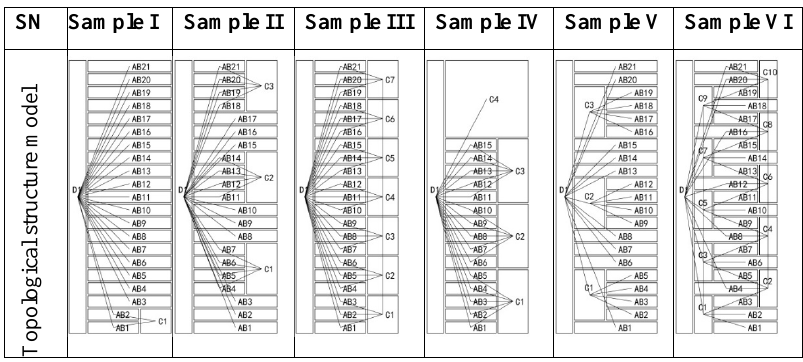
Table 3 Topological structure model.